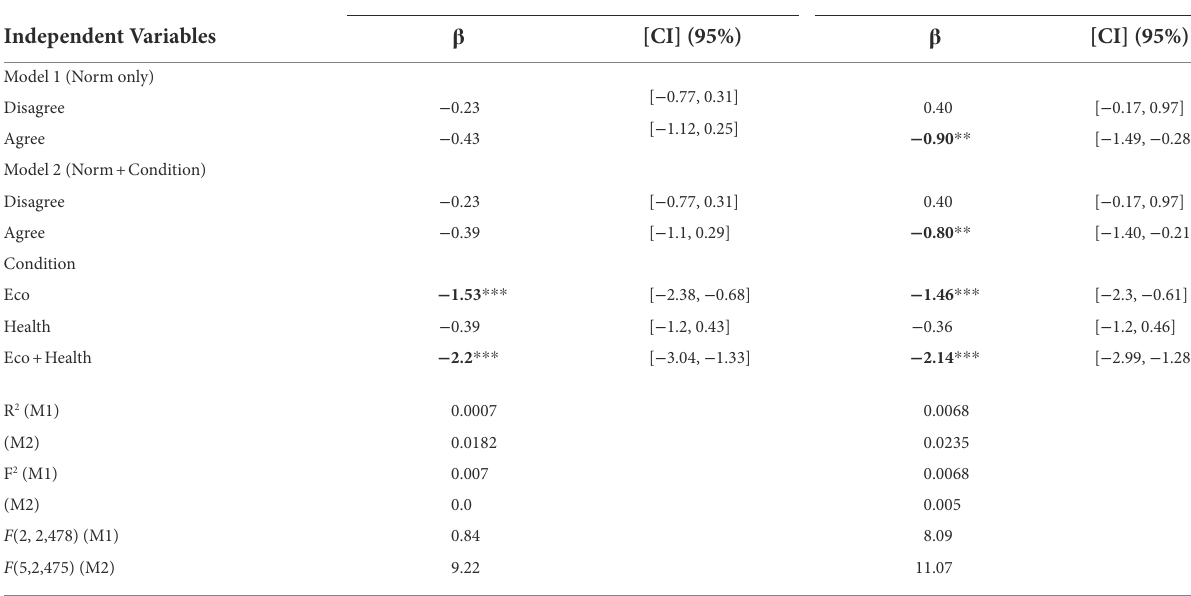
TABLE 3 Linear regression models for effects of environmental social norms and intervention condition on environmental impact of shopping baskets. Environment, Distant Environment,